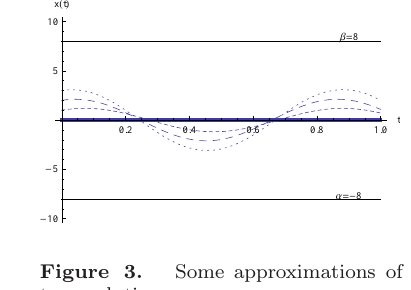
Figure 2. Some approximations of 0 - type solution.